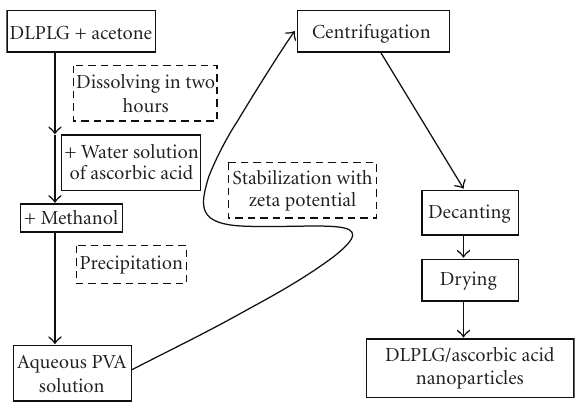
Figure 1: Schematics for obtaining of the DLPLG/ascorbic acid